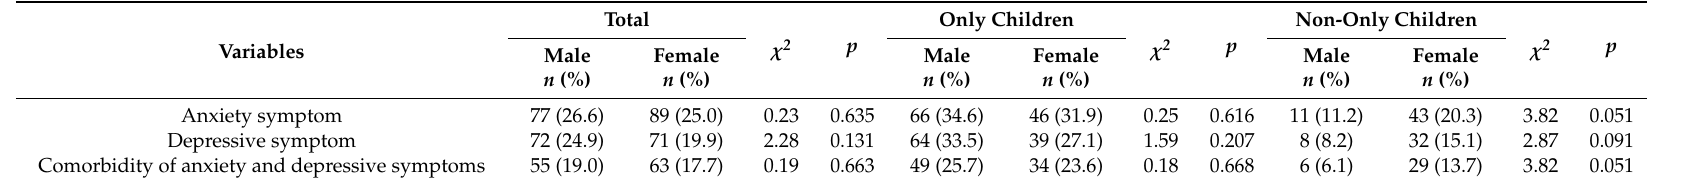
Table 1. Comparison of anxiety and depressive symptoms between males and females by only children or not.